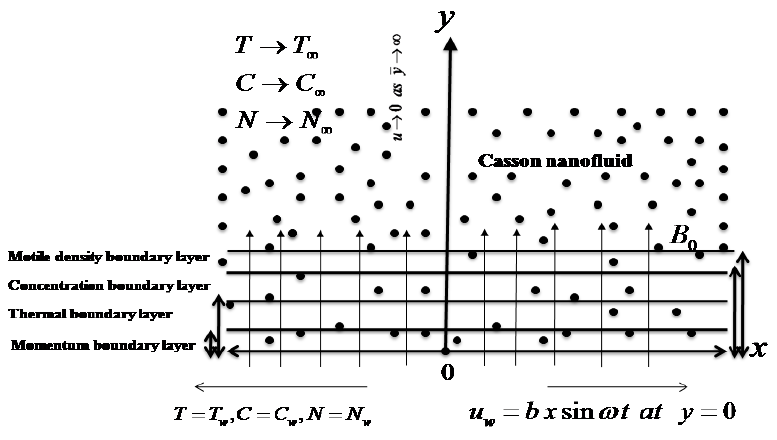
Figure 1. Geometry of problem.